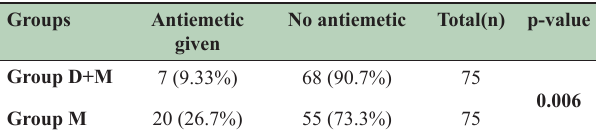
Table-III: Association among the rescue antiemetic